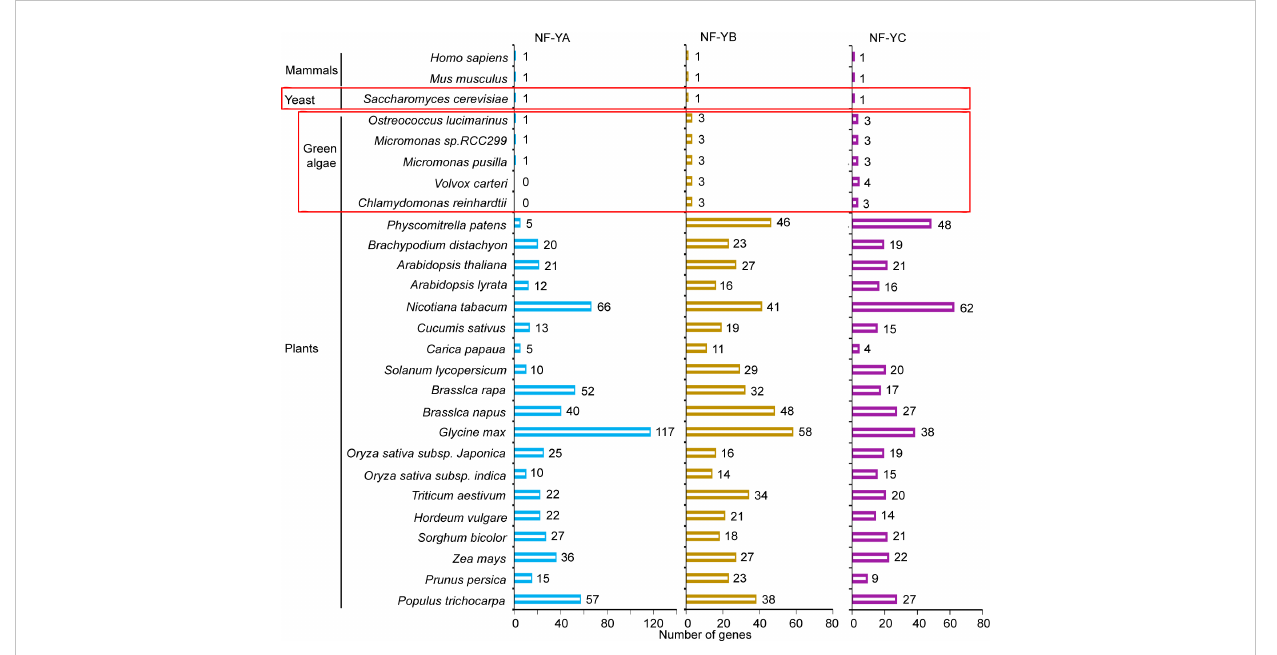
FIGURE 2 NF-Y subunit homologs in different species. Number of gene models of NF-YA, NF-YB, and NF-YC homologs in different species were identi fi ed from the plant transcription factor database, PlantRegMap/PlantTFDB v5.0